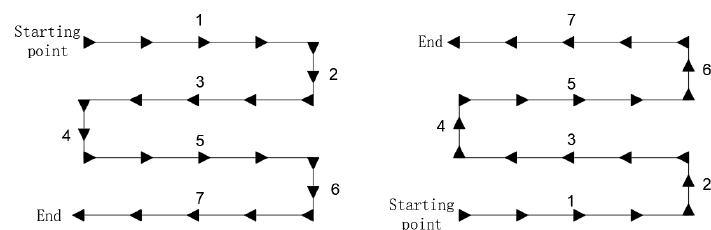
Figure 4. A “snake” cutting path track diagram.